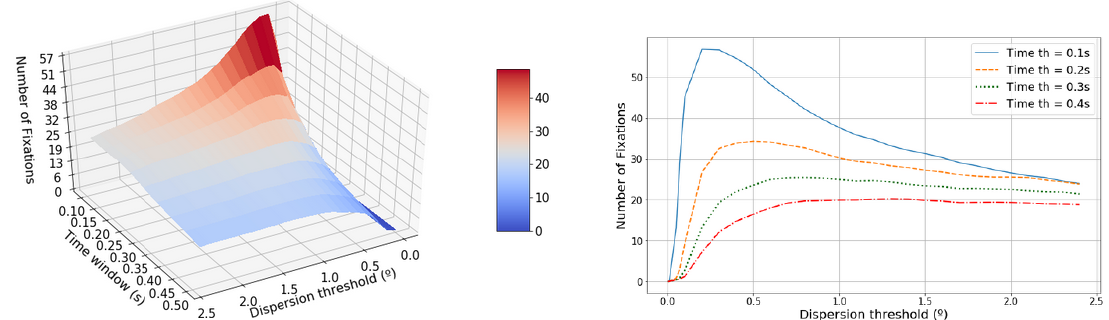
Figure 4. The left-hand graphic shows the evolution of the average number of fixations in terms of the dispersion threshold and the time window. The right-hand graphic shows the projected dispersion threshold.